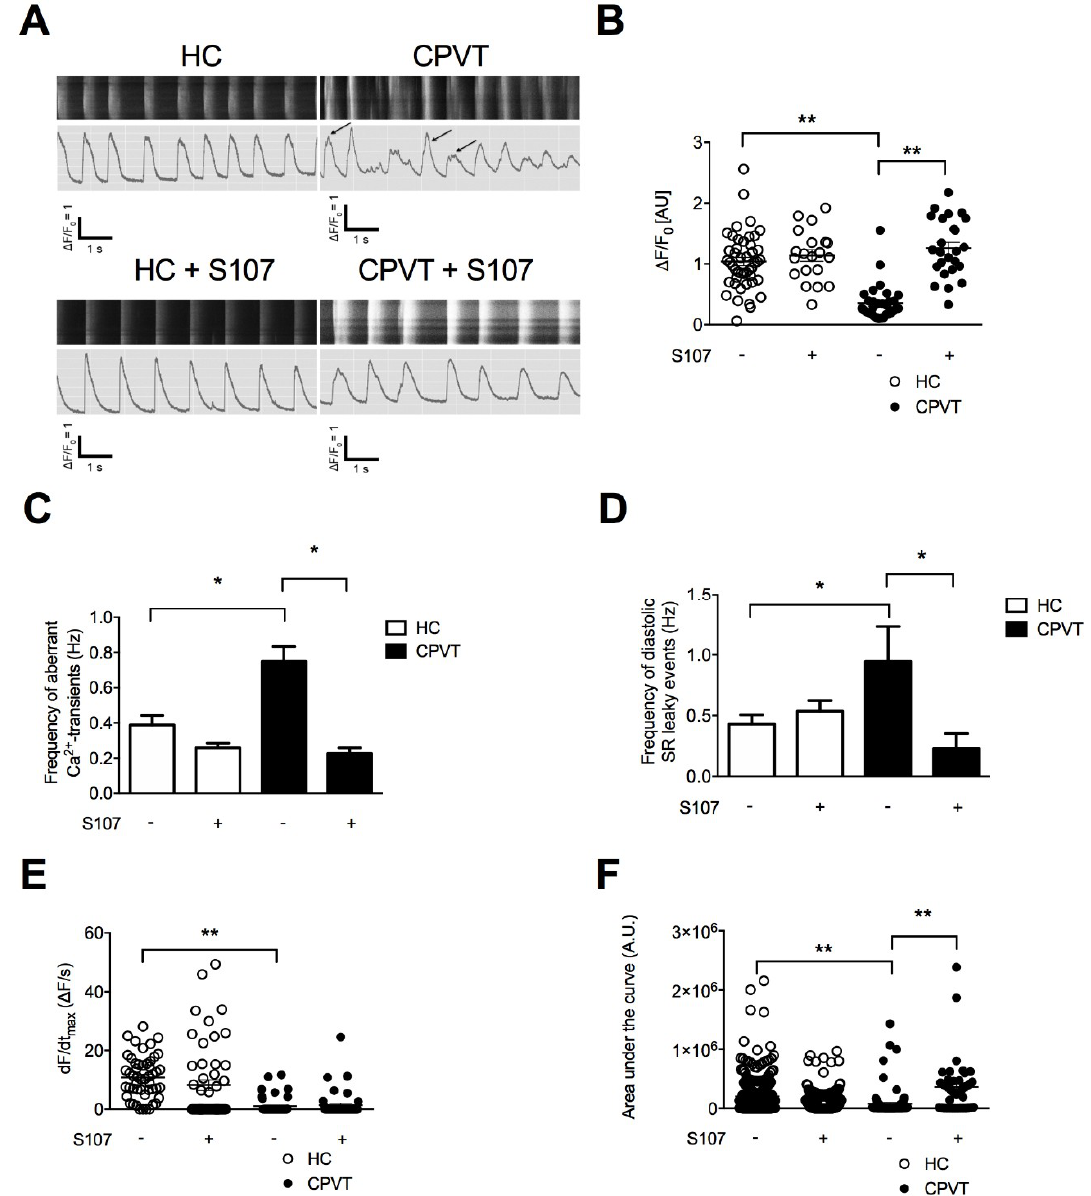
Figure 3. Intracellular Ca 2+ cycling and SR Ca 2+ stores in CPVT hiPSC-CMs under stress. ( A ) Display of original line-scan images of Ca 2+ transients and corresponding tracings of HC and CPVT C2.2 hiPSC-CMs treated with 1 µ M ISO together with pacing at 1 Hz (20 V, 0.5 ms duration and 1 ms delay) ± 5 µ M S107. Additional and aberrant Ca 2+ release events are shown with the arrows. ( B ) Scatter plots showing maximal Ca 2+ -transient amplitude in HC (white dots) and CPVT (black dots) hiPSC-CMs under stress conditions ± (indicated by the + or − symbols) treated with 5 µ M S107. ( C , D ) Bar graphs showing frequency of occurrence of aberrant Ca 2+ -transients ( C ) and diastolic SR leaky events ( D ) in HC and CPVT hiPSC-CMs under stress conditions ± (indicated by the + or − symbols) treated with 5 µ M S107. ( E , F ) Rate of RyR2 Ca 2+ release (dF/dt max ) and area under the curve (peak area) in HC and CPVT hiPSC-CMs under stress conditions ± (indicated by the + or − symbols) treated with 5 µ M S107. The number of experiments varies from 20 to 46 for each scatter plot. Data are presented with mean ± SEM. * p < 0.05; ** p < 0.01.